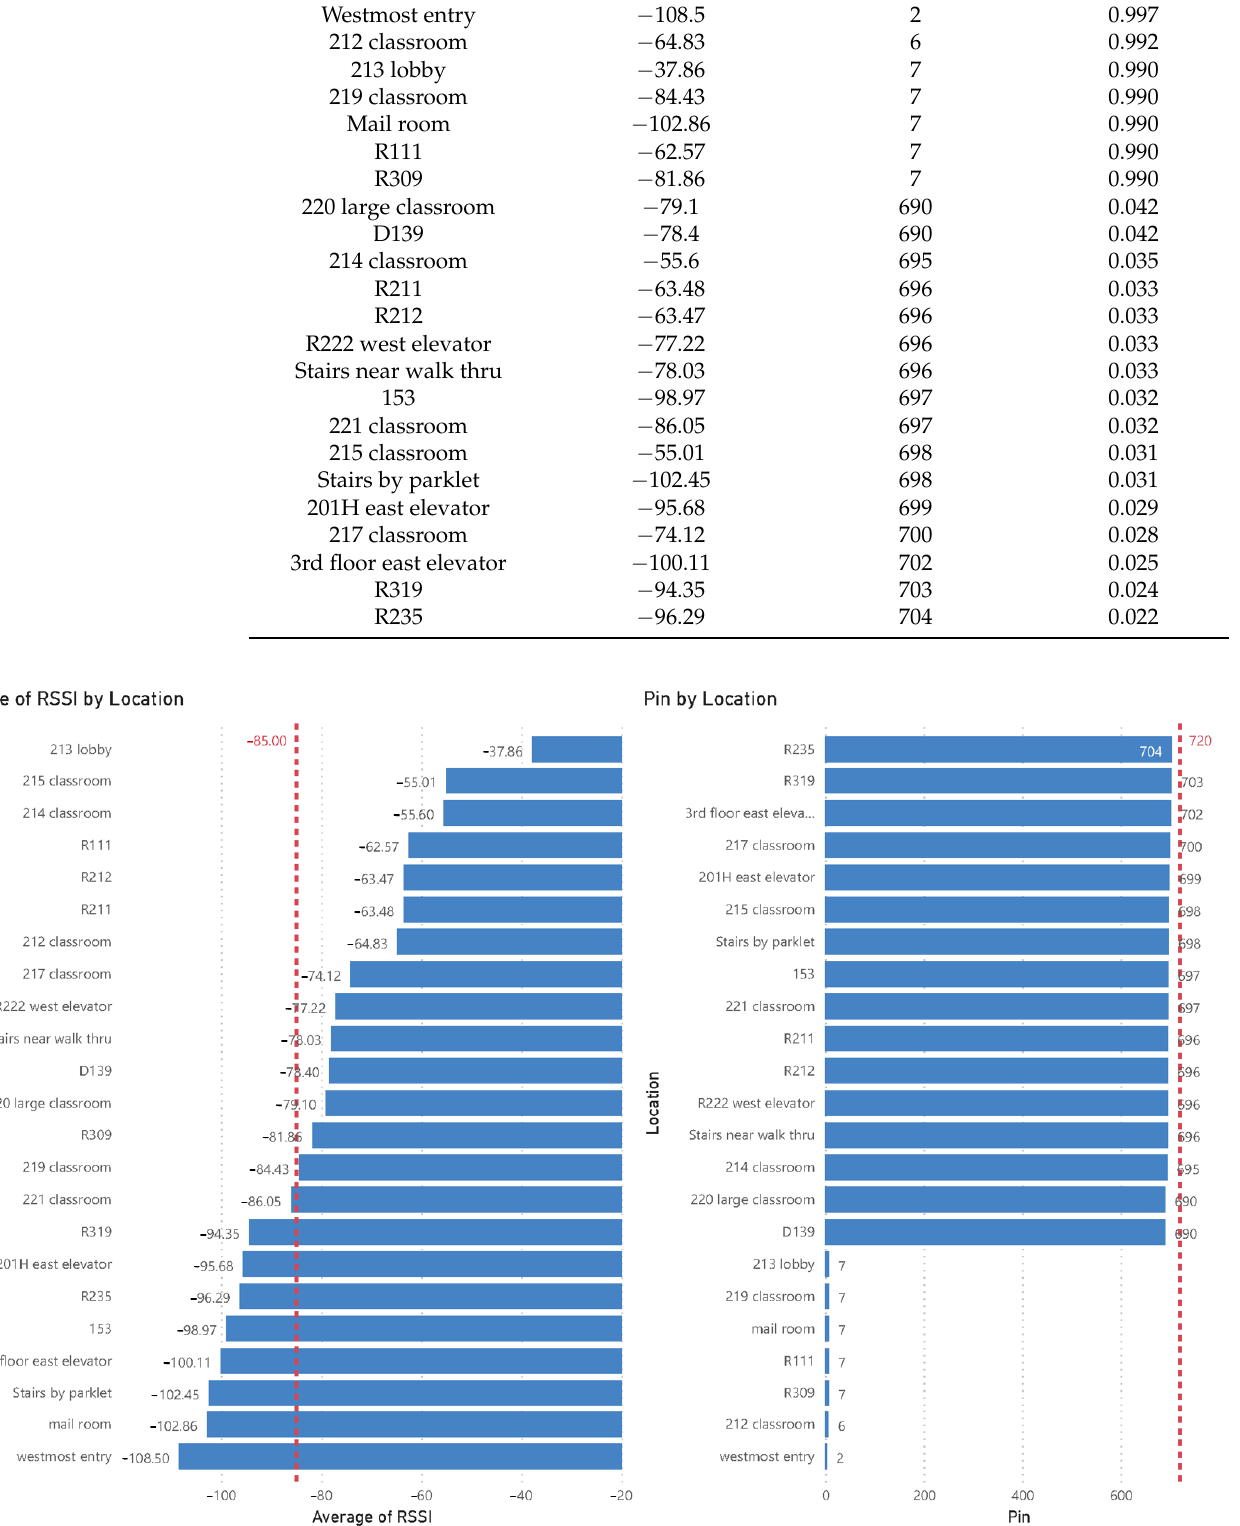
Figure 12. Sensor signal quality and received events by location (from field tests).